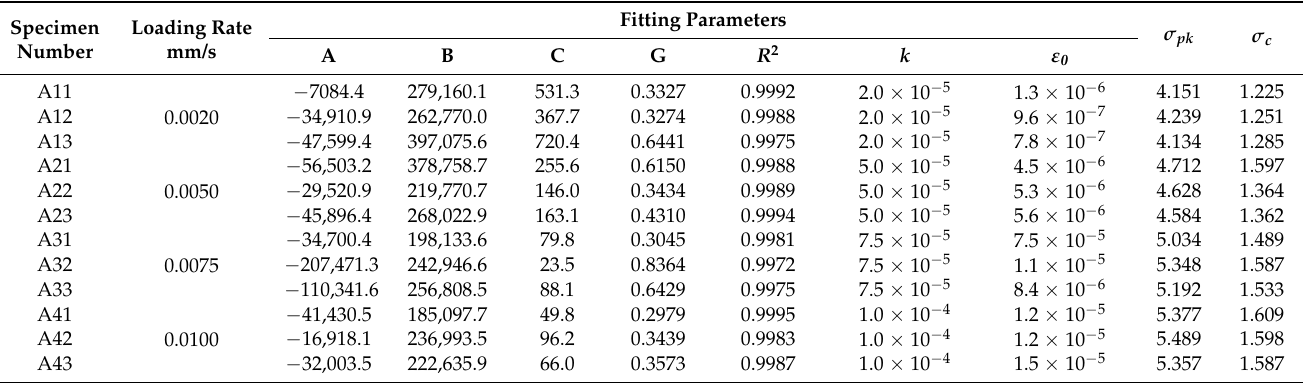
Table 5. Fitting parameters of different loading